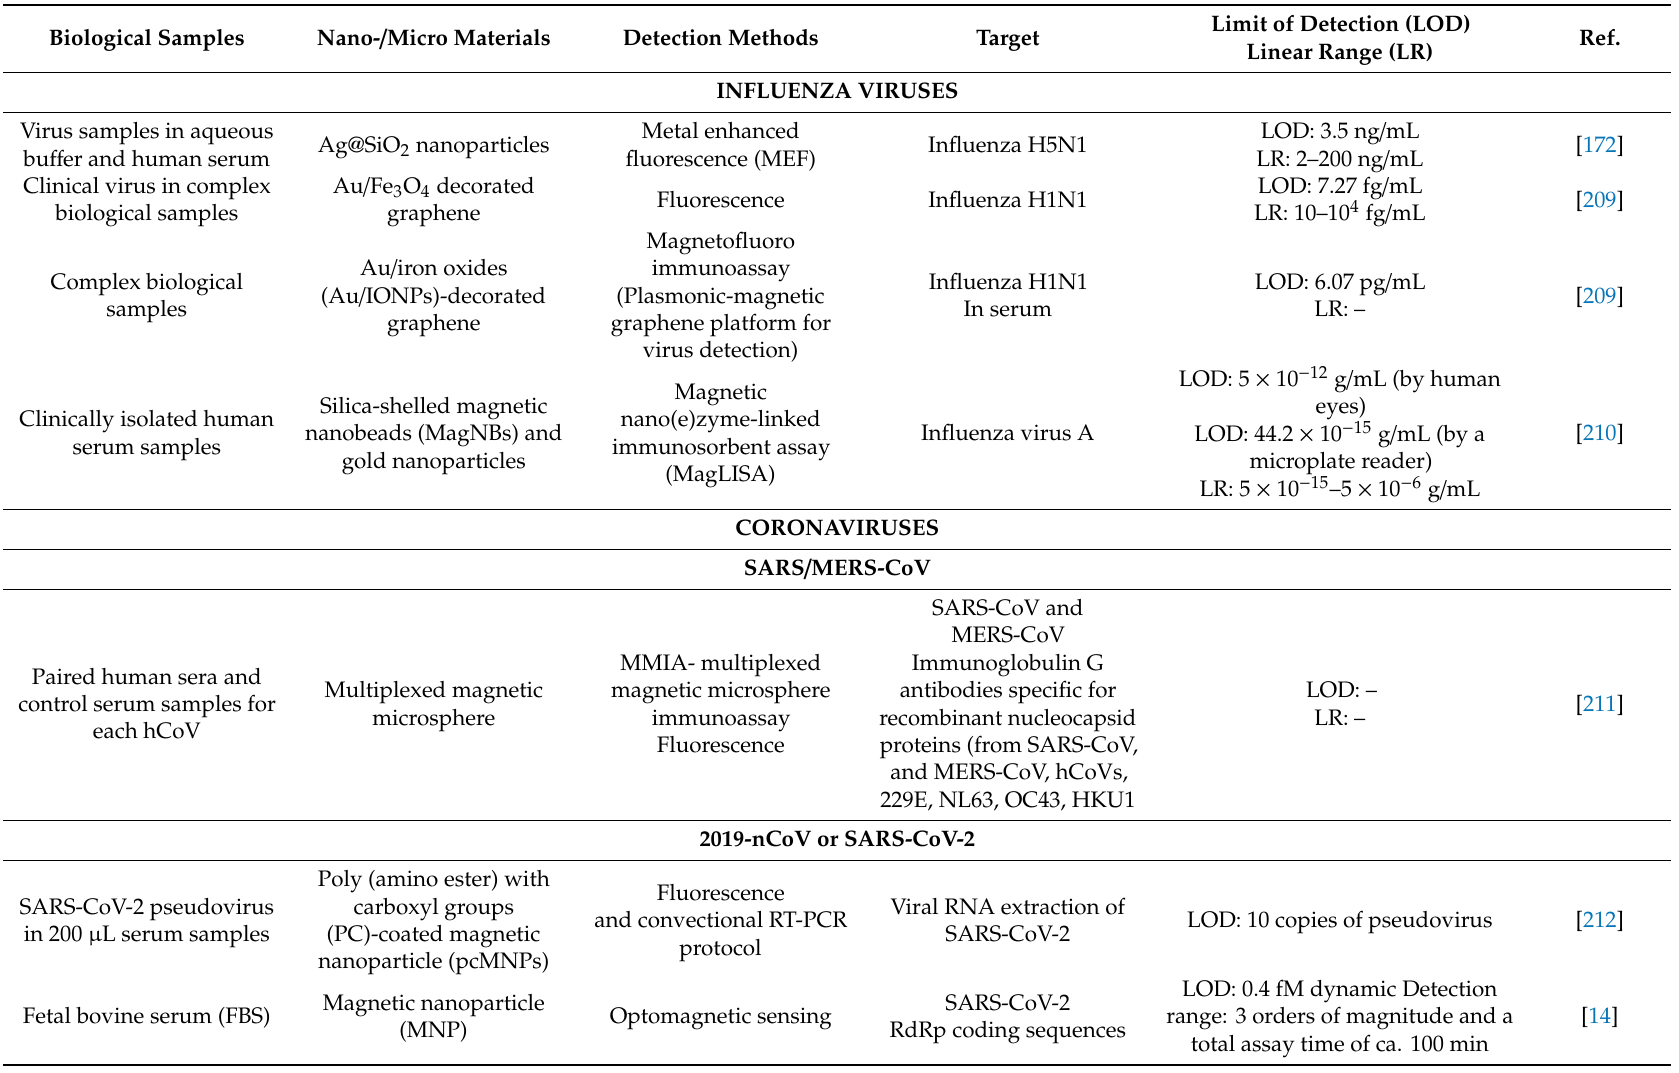
Table 5. Magneto-optical detection method and their parameters for human coronaviruses including COVID-19 causative virus and influenza